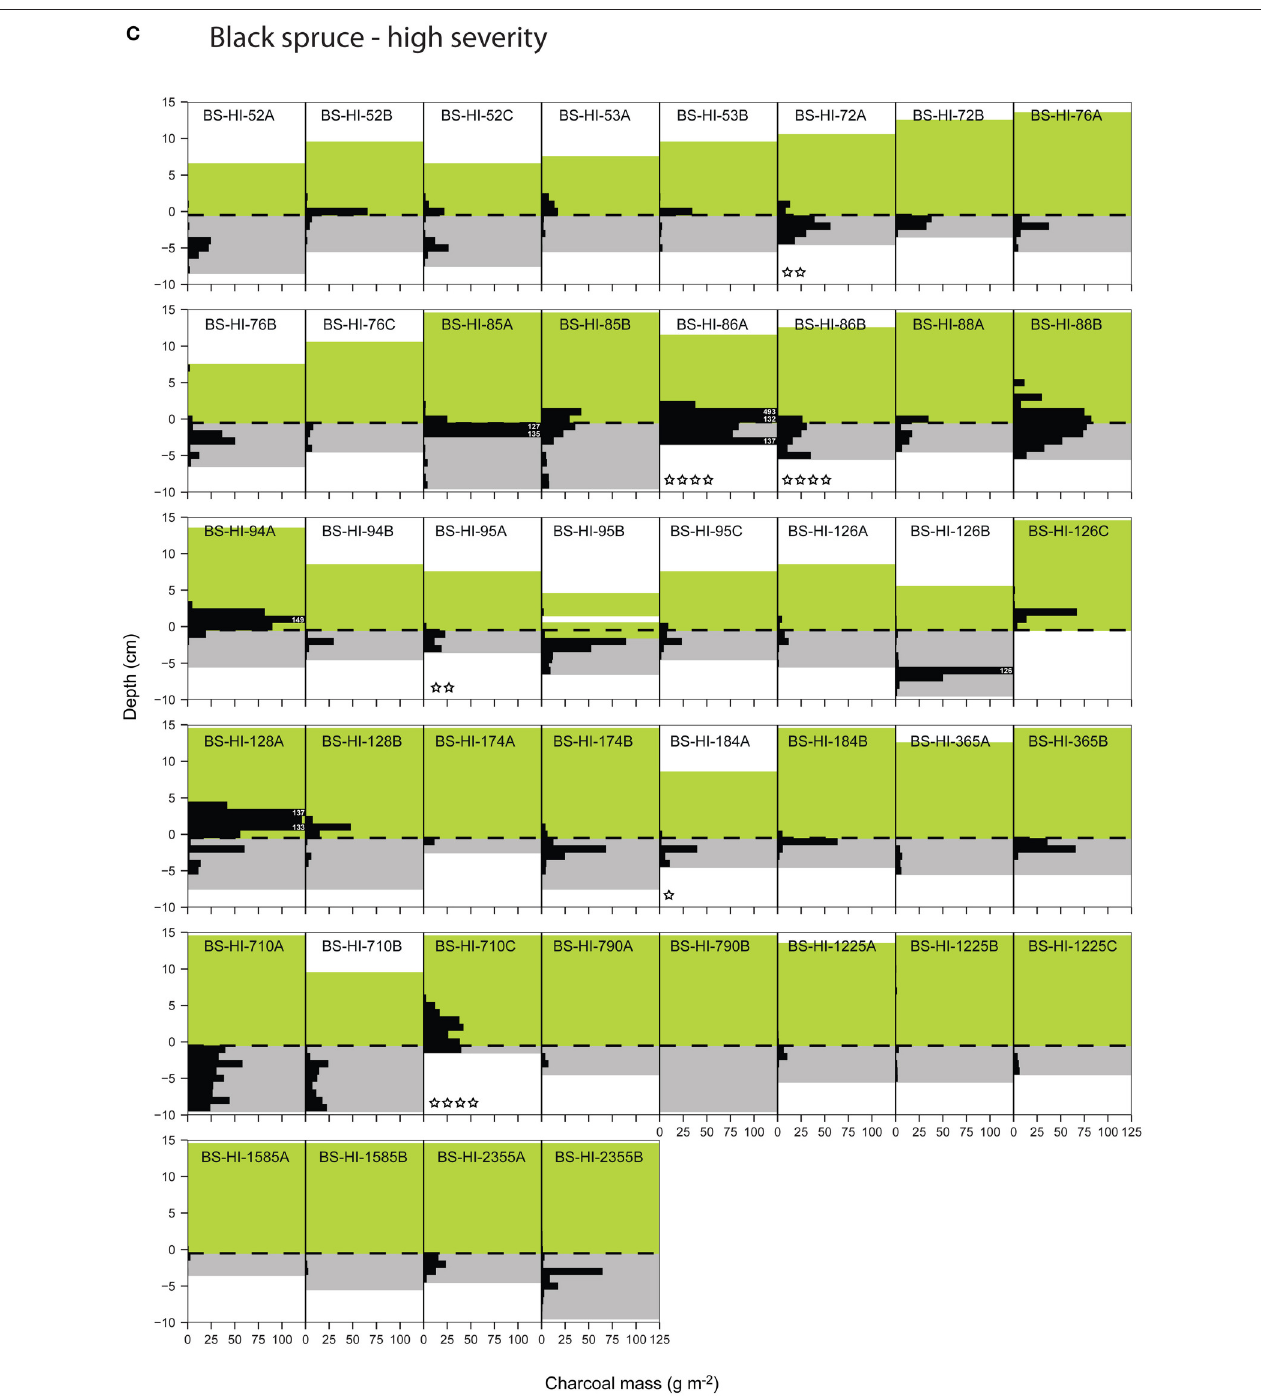
FIGURE 2 | Depth distributions of charcoal by 1-cm increments for each monolith in (A) jack pine, (B) low-severity black spruce, and (C) high-severity black spruce sites. The black horizontal bars represent charcoal mass up to a value of 125g m − 2 ; when charcoal mass exceeds this value, the exact value is indicated in small white characters. The green area above the organic-mineral interface (dashed line at depth = 0) represents the organic layer, and the gray area below the interface represents the mineral soil that was sampled. For some monoliths, sampling was probably not deep enough to capture the charcoal peak (e.g., JP-HI-76B and JP-HI-135B). To quantify how likely charcoal abundance was underestimated, we identified (star-shaped symbols) all monoliths whose deepest 1-cm horizon contained a significant proportion ( > 10%) of the total charcoal mass and that also had a significant amount of charcoal: > 10g m − 2 : 1 star; > 15g m − 2 : 2 stars; > 20g m − 2 : 3 stars; > 25g m − 2 : 4 stars. Monoliths that most likely under-sampled the charcoal (4 stars) are identified as open bars in Figure 1 .